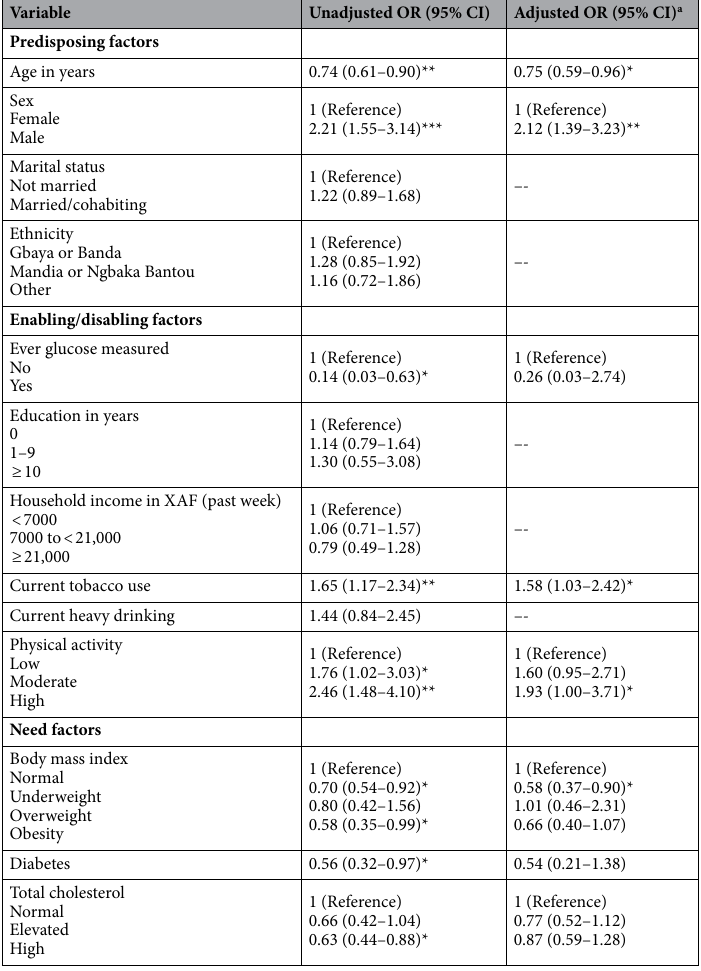
Table 2. Univariable and multivariable logistic regression reporting unadjusted and adjusted Odds Ratios (OR) for factors associated with undiagnosed hypertension in adults with hypertension in Central African Republic, 2017. OR Odds Ratio; CI Confidence Intervals; * p < 0.05; ** p < 0.01; *** p < 0.001; a Adjusted for age, sex, ever glucose measured, current tobacco use, physical activity, body mass index, diabetes and total